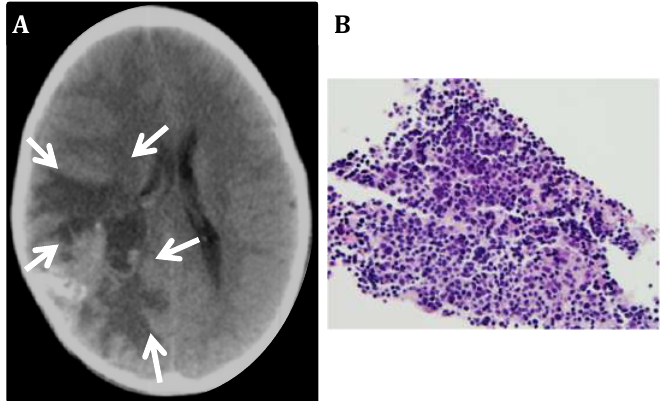
Figure 2. Neuroblastoma metastatic to the CNS. ( A ) Computerized Tomography image of a metastatic NB shows a large poorly delimited mass in the right posterior frontoparietal region of the brain (arrows). ( B ) Biopsy of the metastatic tumor mass shows small poorly differentiated cells with hyperchromatic nucleus and scant cytoplasm.